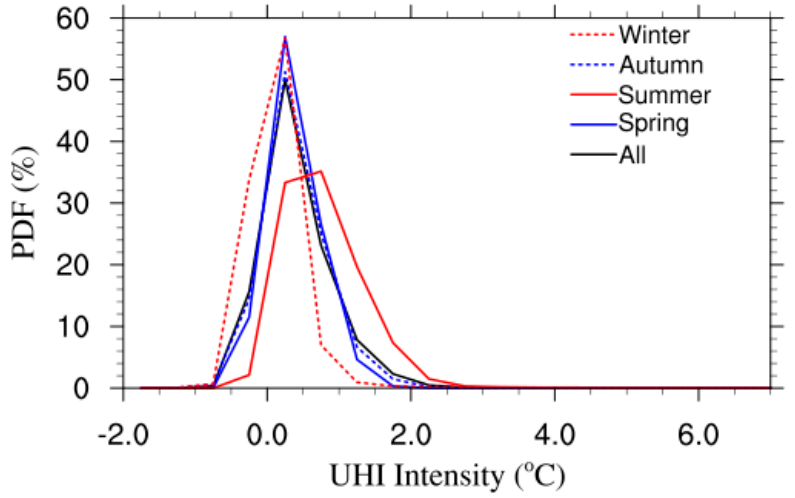
Figure 7. The probability distribution functions of hourly urban heat/cool island intensities.